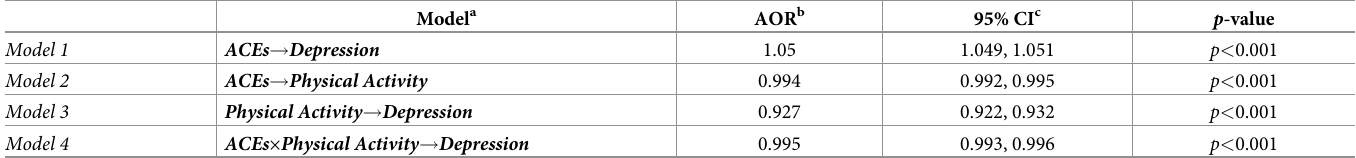
Table 2. Statistical models and results for the Associations between Adverse Childhood Experiences (ACEs), physical activity, and depression among U.S. adults (n = 117,204).